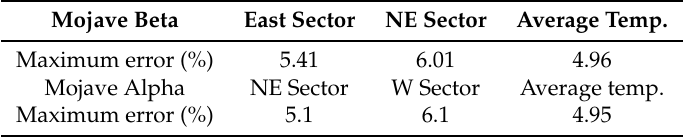
Table 2. Maximum error between the model output and the real